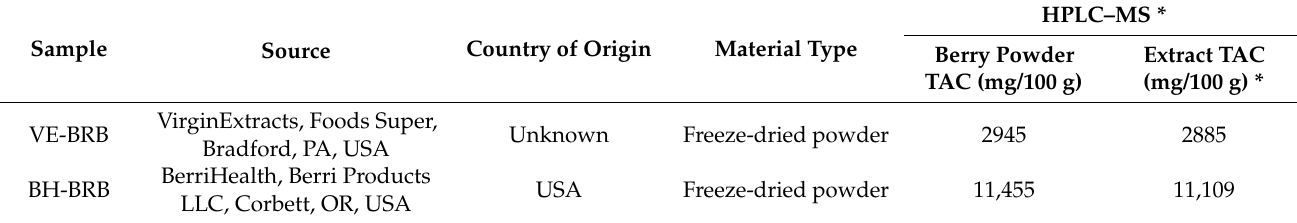
Figure 1. Preparation and anthocyanin content analysis of black raspberries, red raspberries and blackberries. ( A ) Workflow for berry preparation and analysis. ( B ) Representative LC-MS spectrum of a berry preparation. Major peaks represent cyanidin-3- O -glucoside, cyanidin-3- O -rutinoside, and a combination of cyanidin-3- O -xylosylrutinoside and cyanidin-3- O -sambubioside. ( C ) Total anthocyanin content (TAC) in suspended powders and ethanol extracts of black raspberries (BRB), red raspberries (RRB) and blackberries (BB) determined by LC-MS. Individual data points, mean and SD are shown. ( D ) TAC in powders and extracts of BRB, RRB and BB purchased as fresh-frozen berries or as freeze-dried berry powder. Pooled data from all berries; individual data points, mean ± SD are shown. ( E ) Concentrations of major anthocyanins in suspended powders of BRB, RRB and BB. Statistically significant differences as determined by ( C , D ) Student’s t test ( E ) or two-way ANOVA are shown as * p < 0.05, ** p < 0.01 and *** p < 0.001. Table 1. Total concentrations of anthocyanins in black and red raspberry and blackberry powders and extracts determined by